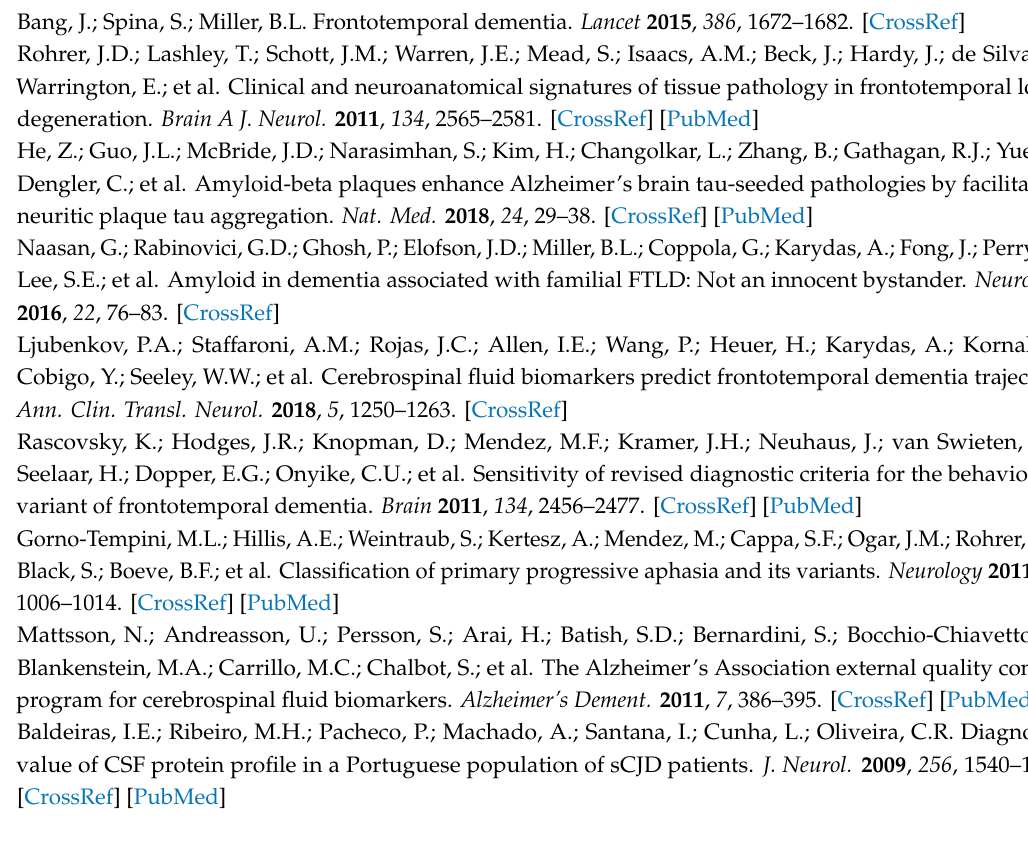
Table S1: Comparison of the two groups in terms of vascular risk